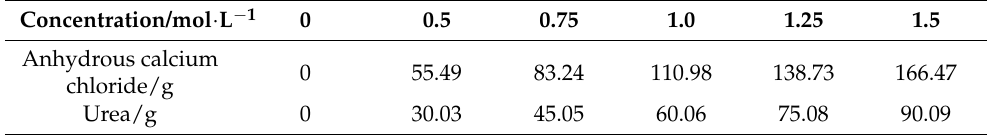
Table 3. Compositions of cementation solutions with different